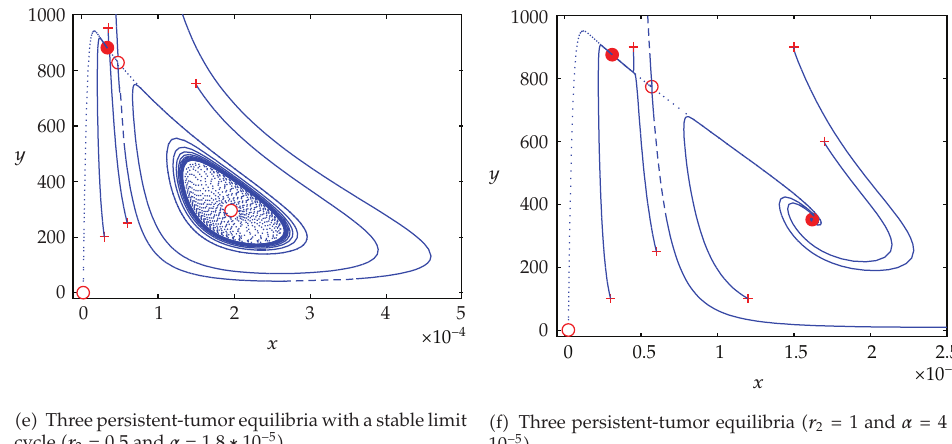
Figure 6: The phase spaces at di ff erent equilibria where stable steady states (cid:6) • (cid:7) , unstable steady states (cid:6) (cid:8) (cid:7) , stable manifold (cid:6) - - - (cid:7) , unstable manifold (cid:6) ··· (cid:7) , and initial conditions (cid:6)(cid:9)(cid:7) , exist. (cid:4) with immunotherapy with both ACI and IL-2, see Table 1 and s 1 (cid:8) 40, s 2 (cid:8) 10. (cid:5)